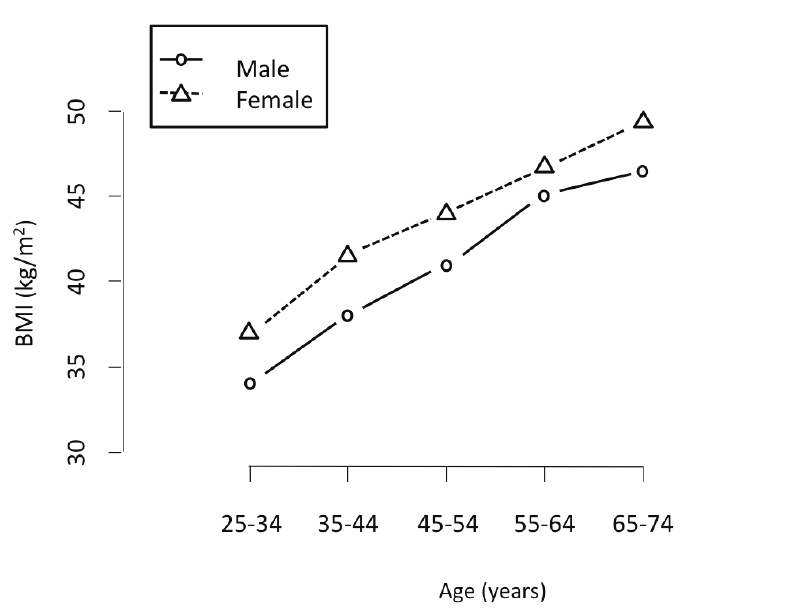
Figure 5: Threshold for surgery being cost-saving Threshold Body Mass Index (BMI) above which Gastric Bypass surgery is cost saving compared to conventional